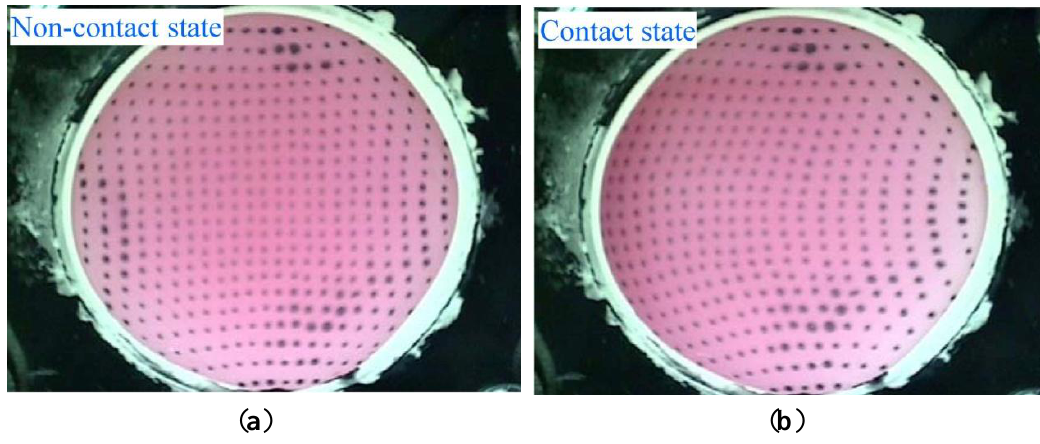
Figure 2. The image captured by the CCD camera when ( a ) the touchpad is not in contact with an object; and ( b ) when the touchpad contacts an object moving in the tangential